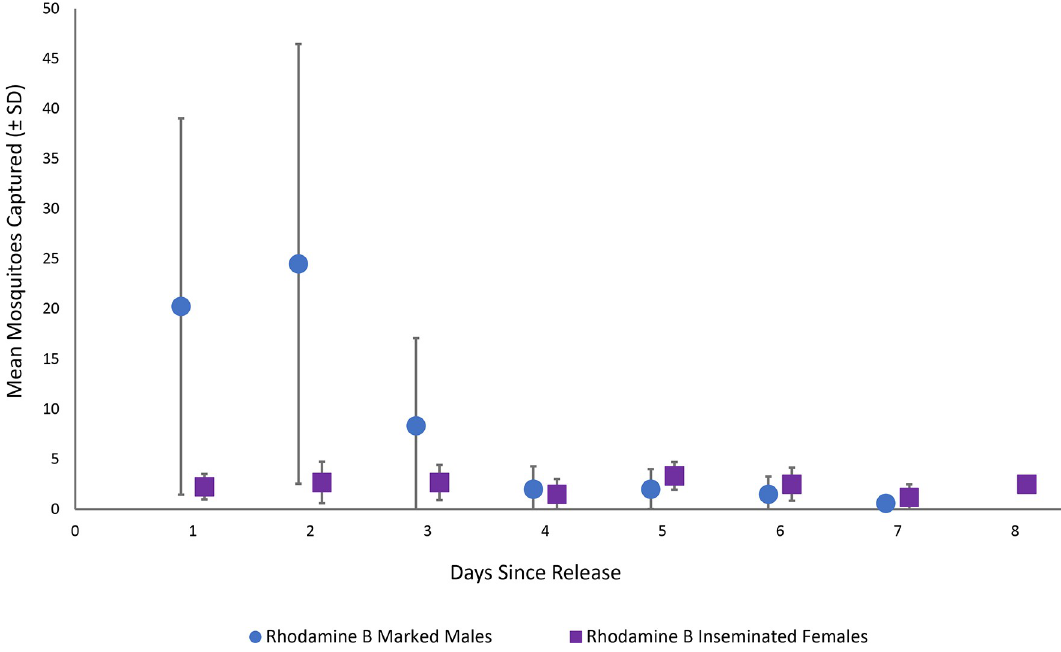
Fig 2. Daily mean recapture rate ( ± SD) of rhodamine B marked male (blue circles) and inseminated female Aedes aegypti (purple squares) in South Innisfail, Australia. Data aggregated across all mark-release-recapture experiments.